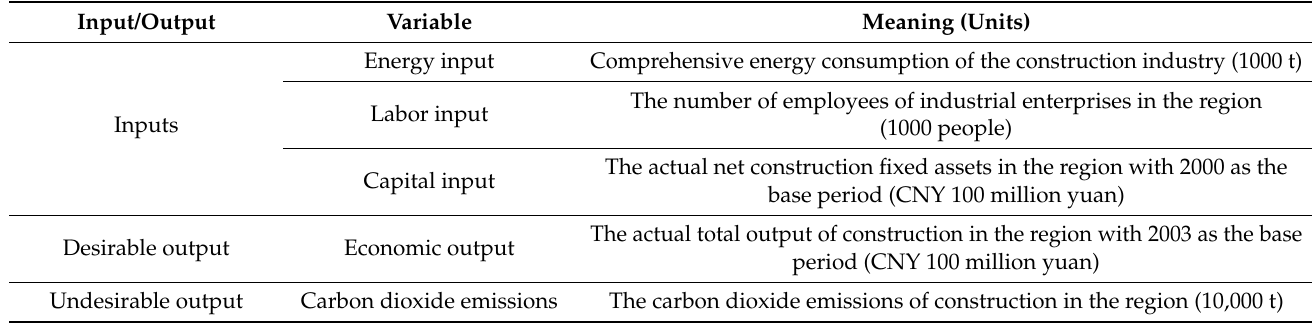
Table 1. Measurement index of CIGTFEE of the construction